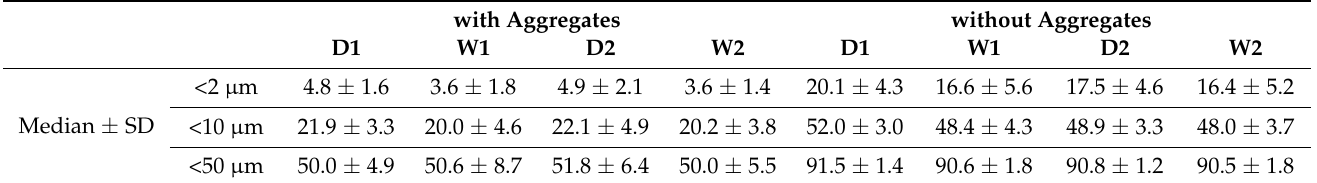
Table A6. Aggregate representation percentage in the sediment depending on initial condition, slope 22° [%].